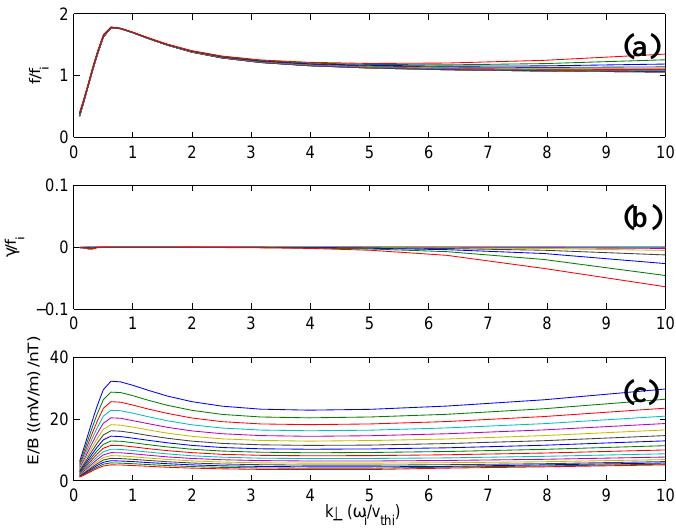
Fig. 12. Solutions from WHAMP code. (a) shows the real part and (b) shows the imaginary part of frequency of ion Bernstein modes with k k =0.06 (orange)– k k =0.01 (blue among cluster of lines) normalized to ion cyclotron frequency at B =85nT as a function of k ⊥ . (c) shows E ⊥ /B ⊥ -ratios. Note that a cyclic color table is used such that k k = 0 . 06 ( k k = 0.01) is corresponding to the curve with lowest (highest) E ⊥ /B ⊥ -ratio and that k k =0.06-solution is most strongly damped (b).